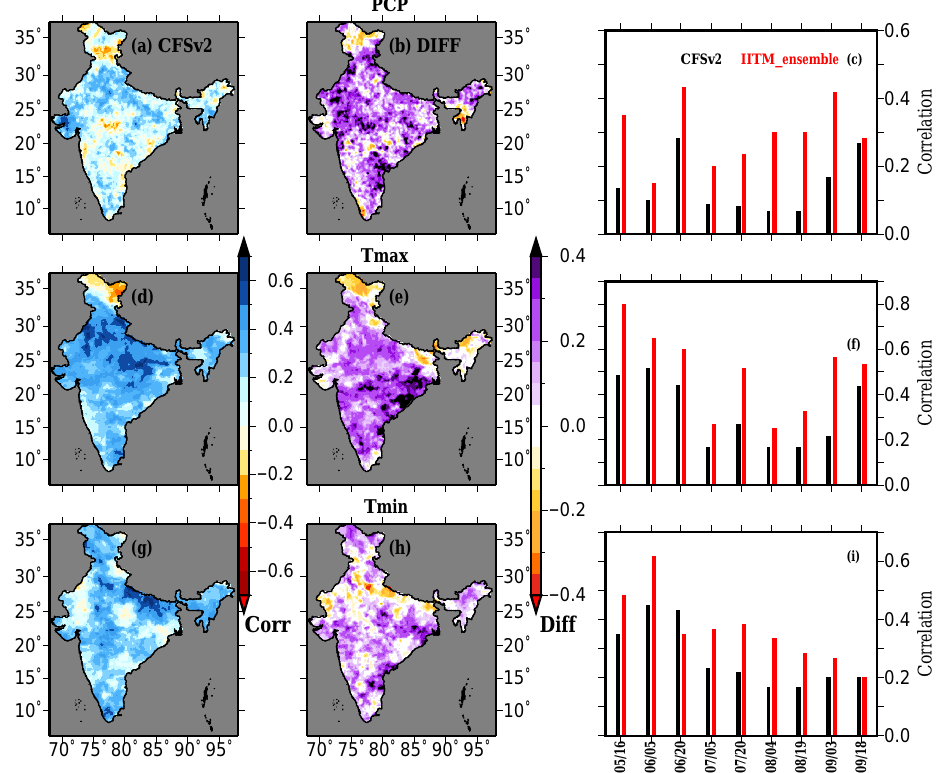
Figure 2. Improvements in correlations in the IITM ensemble forecast in comparison to CFSv2 for the 45-day accumulation period. (a) Cor- relation between precipitation forecast from the CFSv2 and OBS. (b) Change in the correlation coefficient of the precipitation forecast from the IITM ensemble and OBS as compared to (a) . Correlations in (a) and (b) are the median of correlations for the different forecast dates during the monsoon season. (c) All-India averaged median correlation for forecasts initiated on different forecast dates. (d–f) is the same as (a–c) but for daily maximum temperature, and (g–i) is the same as (a–c) but for daily minimum